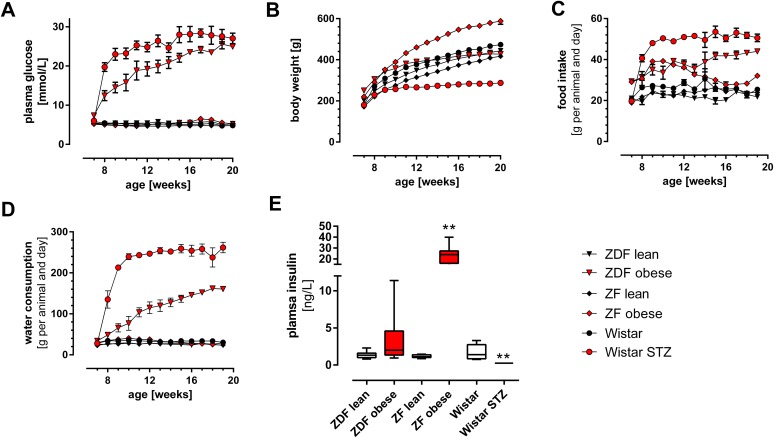
Metabolic parameters in ZDF obese versus ZDF lean rats, ZF obese versus ZF lean rats and Wistar rats without and with single injection of streptozotocin.A, Blood glucose monitored weekly in fed animals B, Body weight C, Food intake, D, Water intake; and E plasma insulin concentrations in fed animals, Mean ± SEM (n = 8) are shown; *) indicates p<0,05 and **) indicates p<0,01 in unpaired student t-test compared to respective control groups.